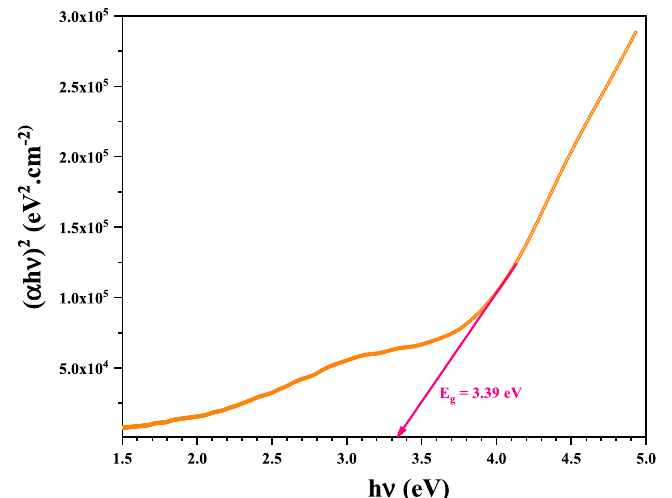
Figure 9. Tauc plot of AgO/Ag NPs prepared by garlic plant